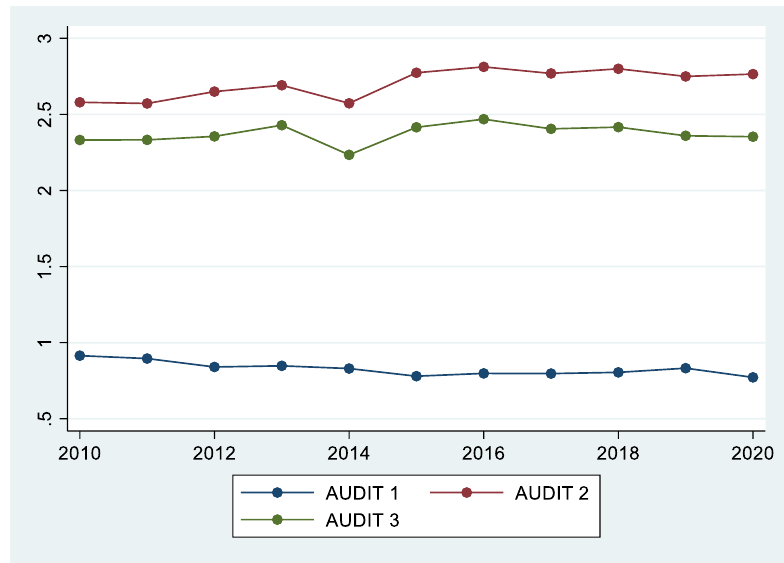
Figure 2. Trends of the three AUDIT items from 2010 to 2020.